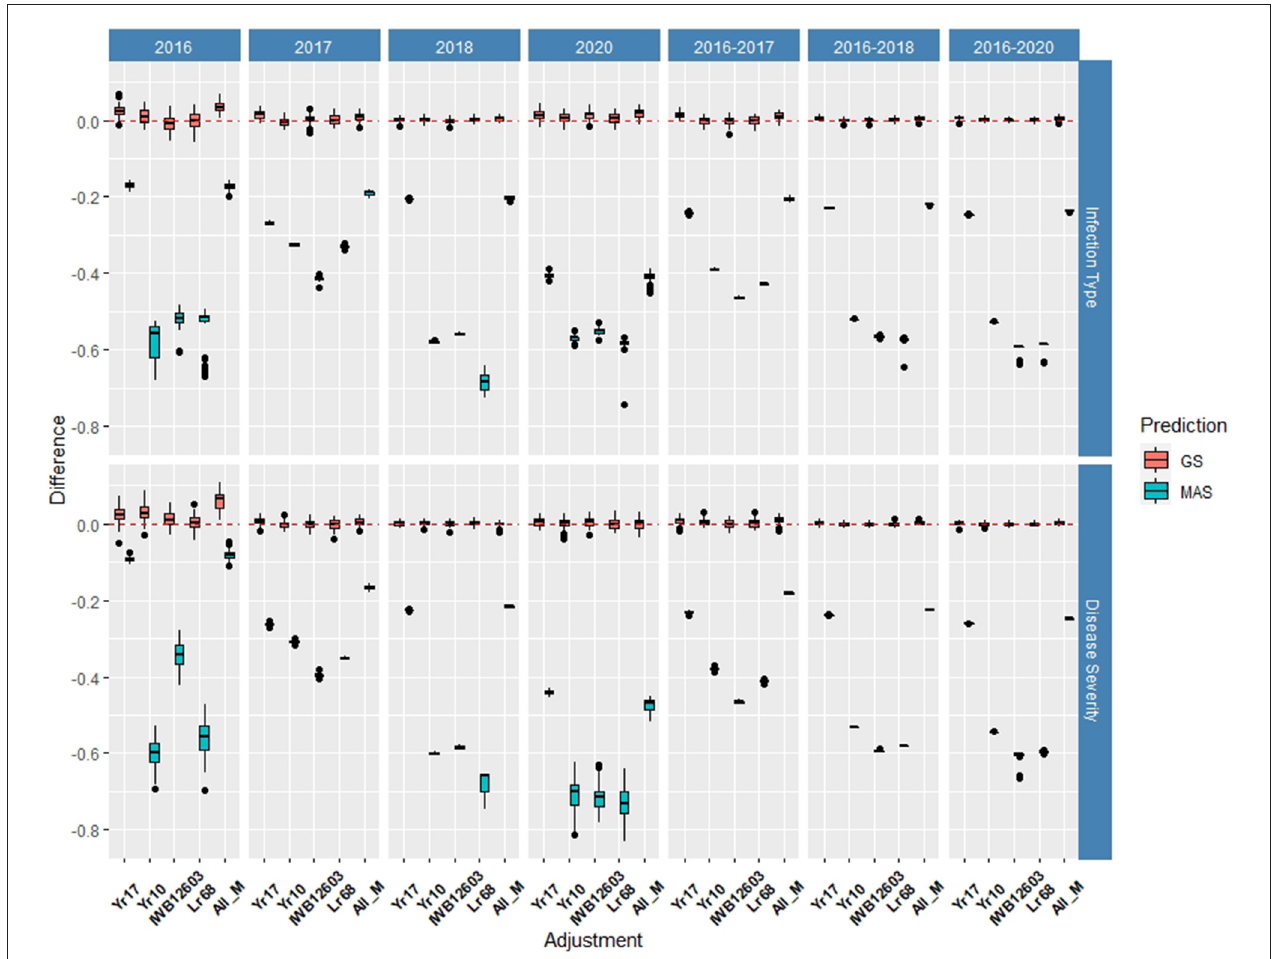
FIGURE 4 | Difference in prediction accuracy from the base rrBLUP model for major markers in genomic selection (GS) and marker-assisted selection (MAS) using cross-validations in the BLs phenotyped from 2016 to 2020. Adjustments: ALL_M, IWB12603(Qyr.wpg-1B.1), KASP(Lr68), Xpsp3000(Yr10), and KASP(Yr17)